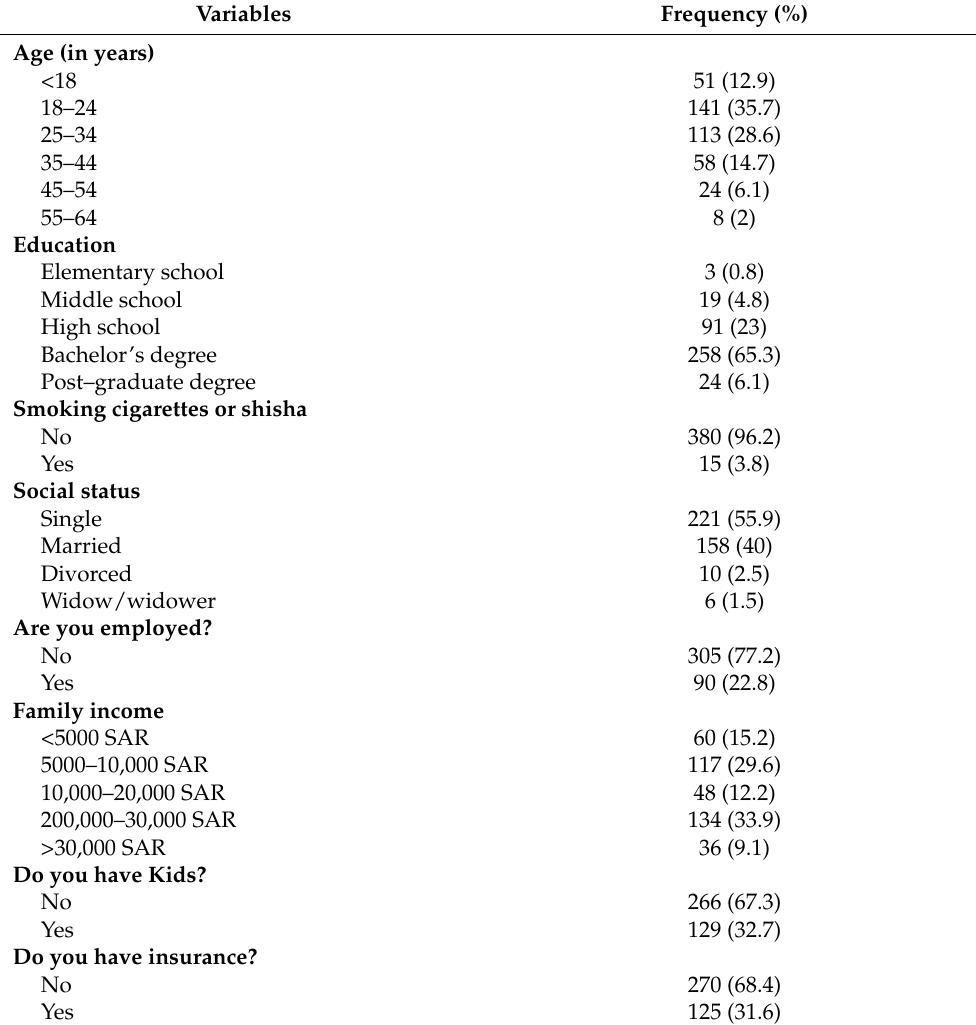
Table 1. Sociodemographic